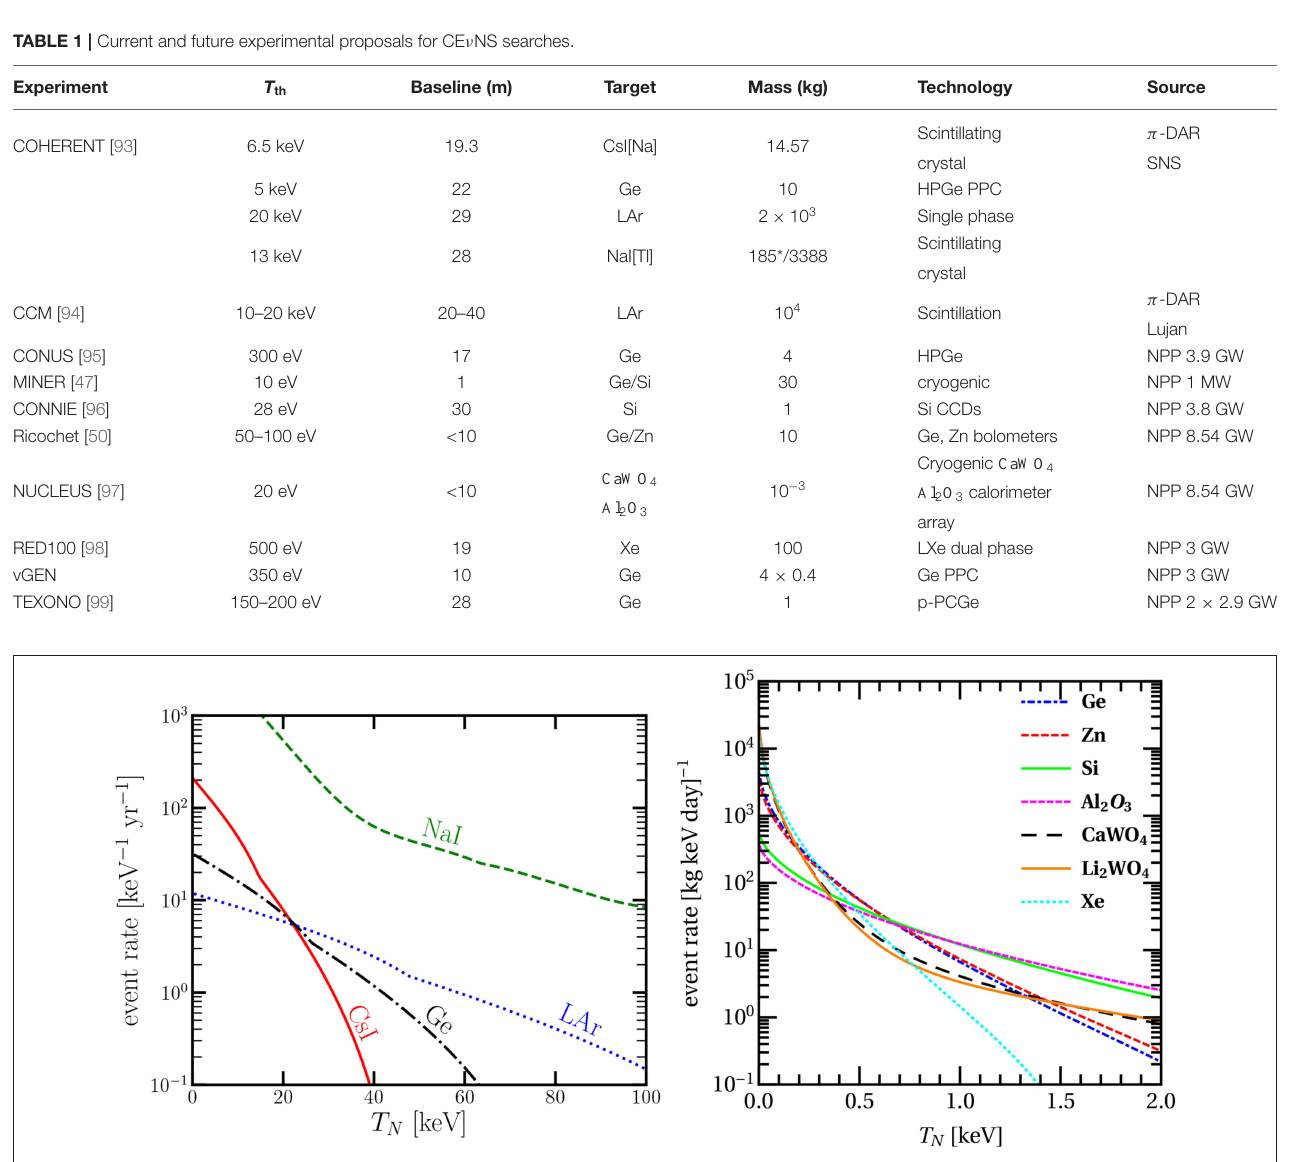
FIGURE 5 | Expected CE ν NS event rate for the different detector subsystems of the COHERENT experiment (Left) and for the different target nuclei relevant to reactor based experiments (Right) . For the case of COHERENT the results are shown according to the setups of Table 1 , while for reactor based experiments the calculation assumes 1 kg of each target located at 20 m from a 4 GW reactor NPP. The impact of QF and efficiency is